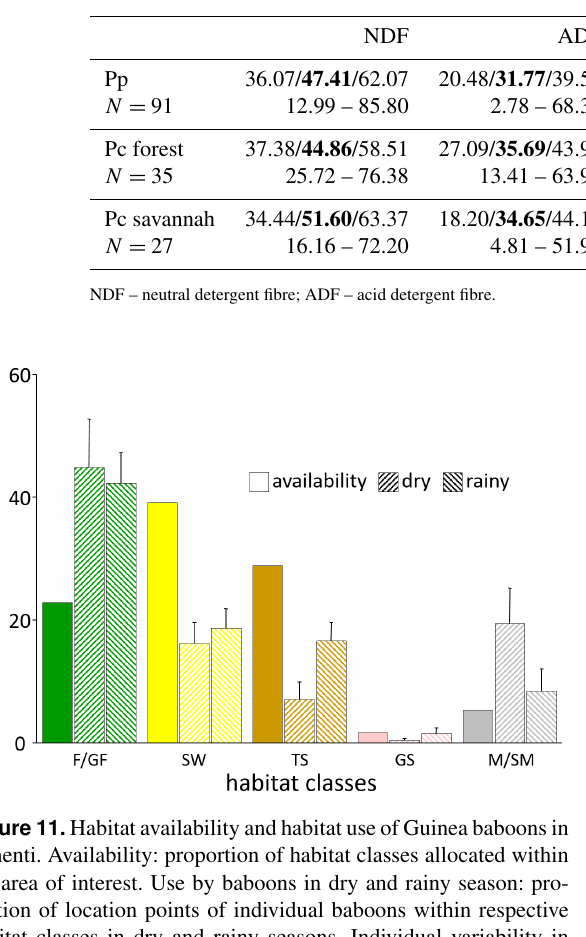
Table 1. Comparison of the chemical composition of vegetable food consumed by Guinea baboons (Pp) at CRP Simenti and by yellow baboons (Pc) in a forest and savannah habitat at the Tana River Primate National Reserve, Kenya (data from Bentley-Condit and Power, 2018). Values are medians , quartiles, and ranges of percentages based on dry matter.